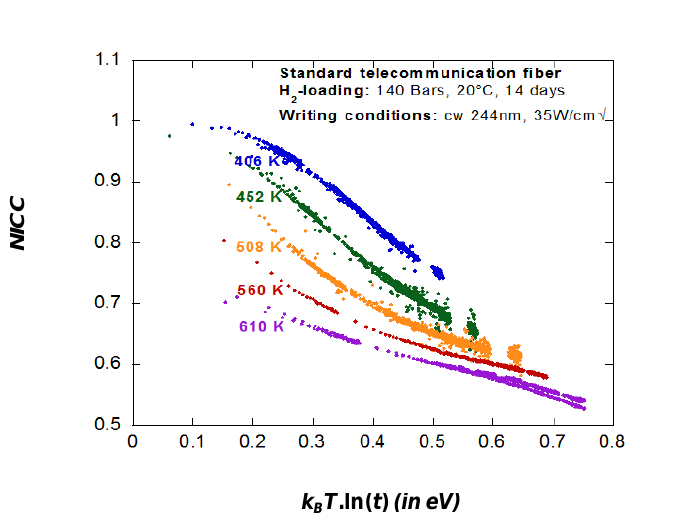
Figure 3. Normalized Integrated Coupling Constant (NICC) as a function of the . T .ln( t ) intermediate variable k B